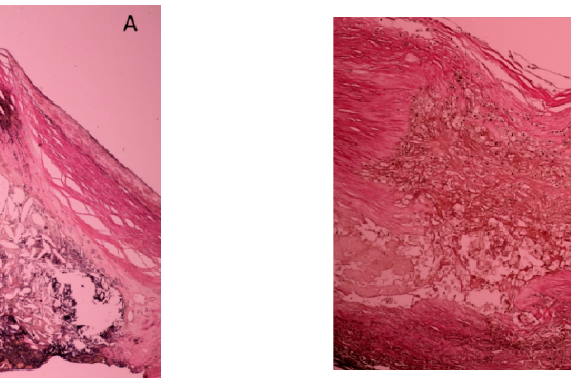
The most relevant histological differences between stable plaque and unstable plaque are shown in Figure 1 (thick FCT versus thin FCT) and in Figure 2.